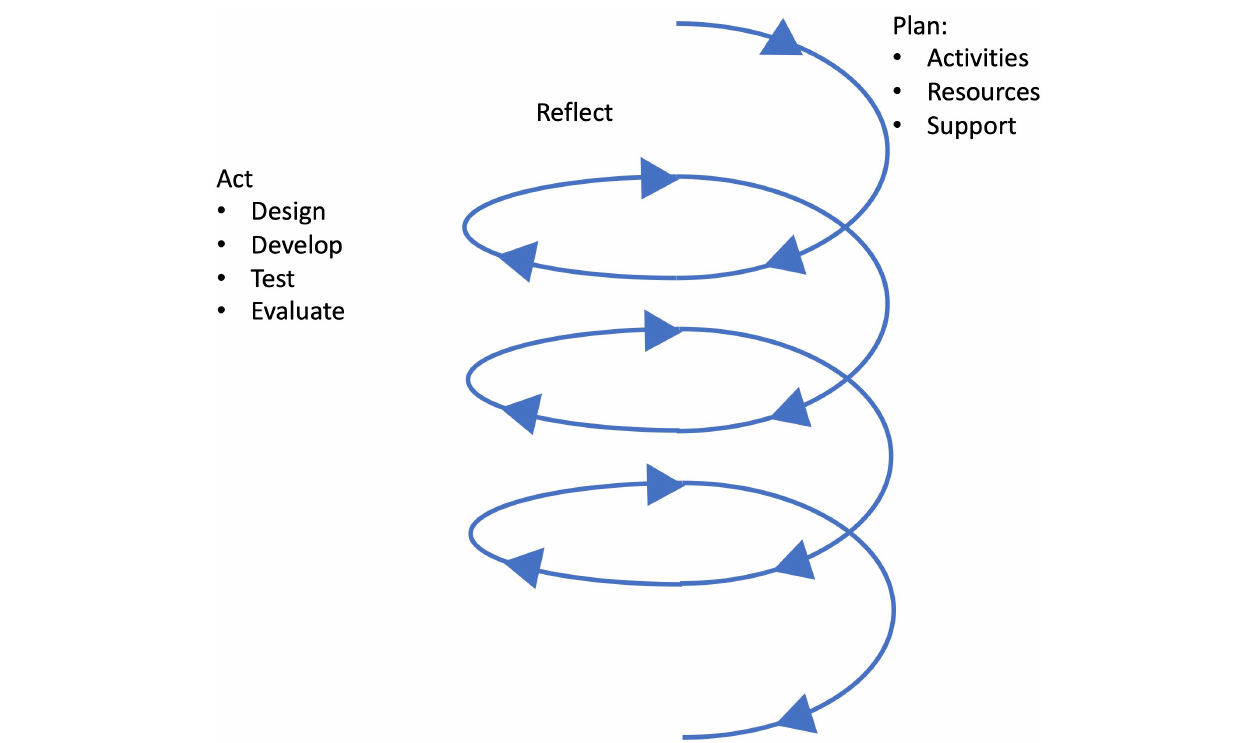
FIGURE 1 | Diagram of iterative research